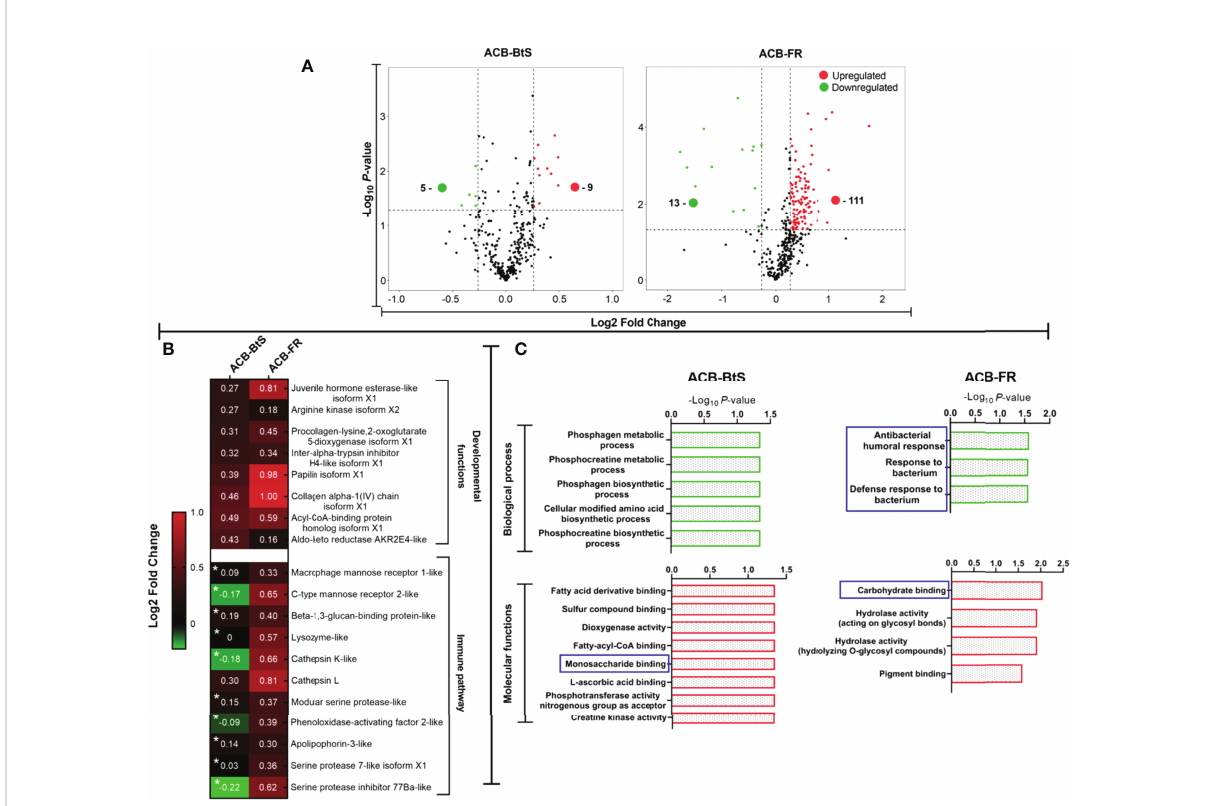
FIGURE 4 Differential protein levels detected in hemolymph from ACB-BtS and ACB-FR larvae after treatment with Cry1F. (A) Hemolymph sample processing and Volcano plot showing the number of proteins with signi fi cantly increased (red dots) or reduced (green dots) abundance in the hemolymph of Cry1F-treated ACB-BtS and ACB-FR larvae compared to controls (Student ’ s t-test, P <0.05). (B) Differentially abundant proteins (DAPs) in hemolymph from Cry1F treated ACB-BtS and ACB-FR larvae involved in developmental functions and immune pathways. Asterisks in the ACB-BtS column indicate proteins with no signi fi cant change in abundance (Student ’ s t-test, P <0.05). A value of 0 indicates the protein was not detected in the DAPs list. (C) Enriched (gene ontology) hemolymph proteins according to biological process and molecular functions in hemocytes from ACB-BtS and ACB-FR larvae after Cry1F treatment. Pathways and respective functions marked in a blue box indicate enrichment of proteins with immune function (-Log10,